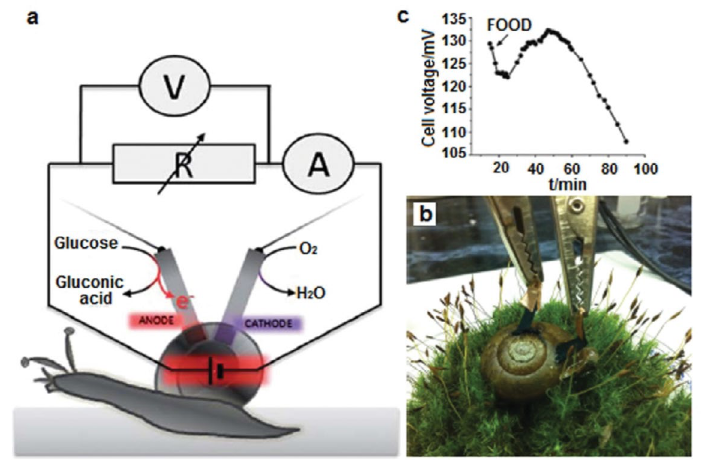
Fig. 17. (a) Circuit for the implanted biofuel cell. (b) Photograph of a snail with implanted biocatalytic electrodes connected with crocodile clips to the external circuitry. (c) Restoring the cell voltage in real time upon feeding the snail [121].